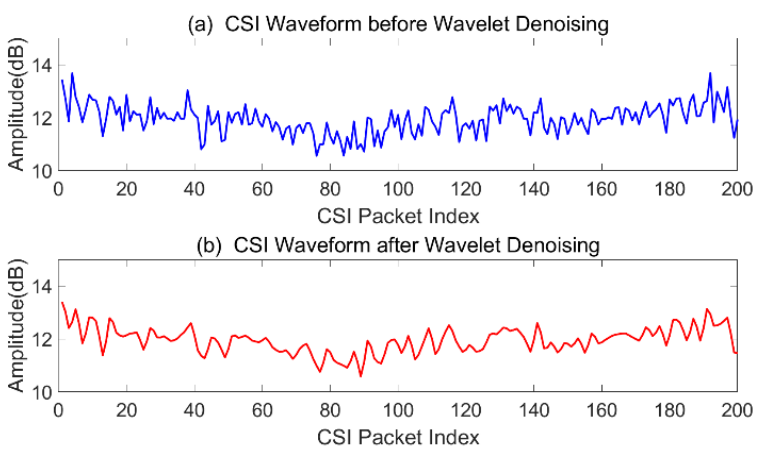
Figure 12. Discrete wavelet transformation (DWT)-based CSI signals de-noising.